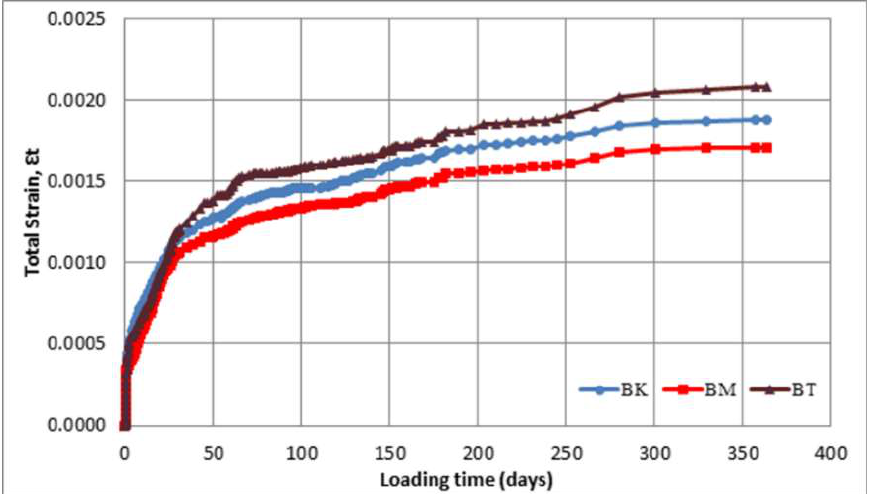
Figure 7. Total strain after sustained loading for 364 days.